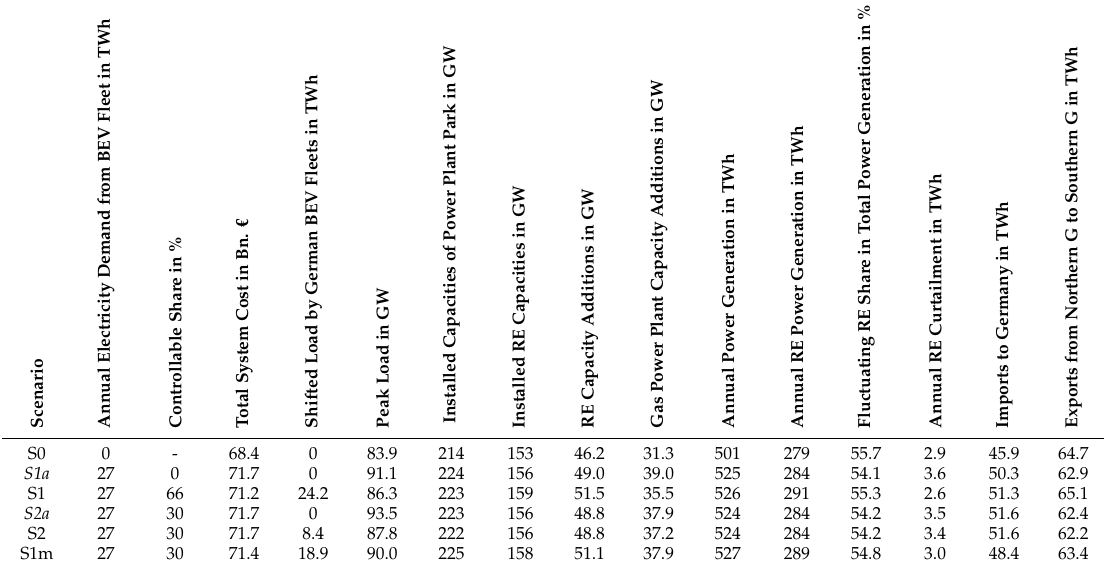
Table A11. Sensitivity scenario results of scenario S1m in comparison with all reference and baseline scenarios S0–S2. Total system costs are given for the complete system boundary while all other values are given for Germany.